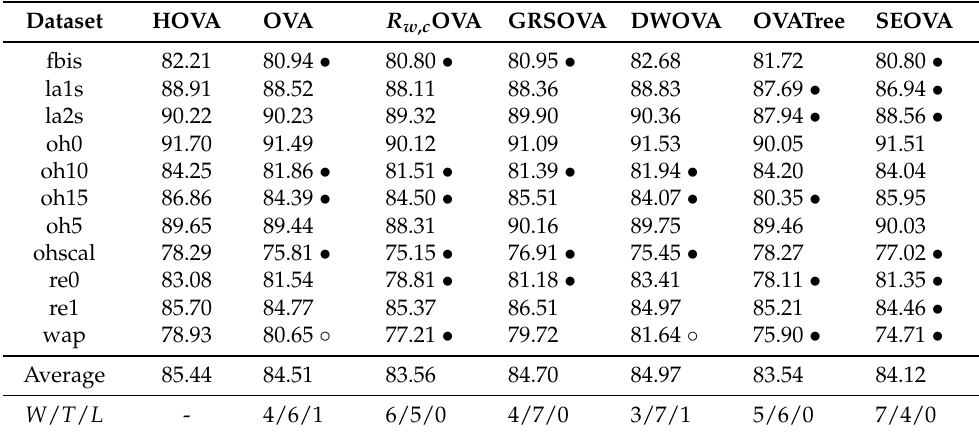
Table 4. Comparisons of the classification accuracy for HOVA versus OVA, R w , c OVA, GRSOVA, DWOVA, OVATree, and